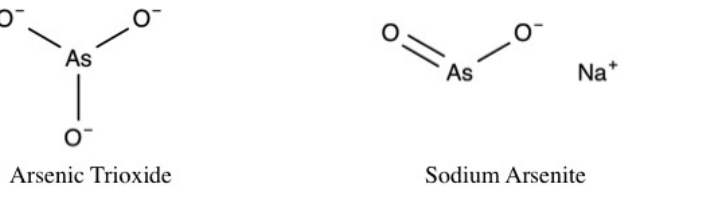
Figure 2. Arsenic species.